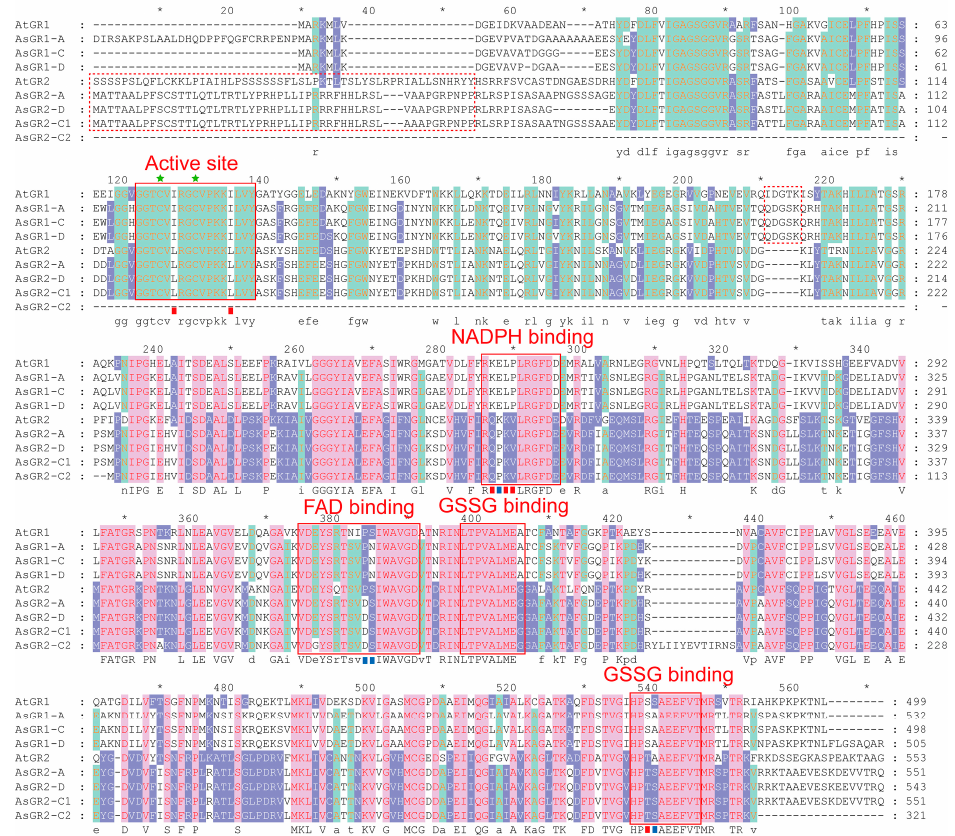
Figure 4. Multiple sequence alignments of AsGR and AtGR proteins. The active site domain, NADPH-binding domain, FAD binding domain, and GSSG binding domain in GR proteins are indicated with a red solid box. The targeting signal peptide for chloroplastic and cytosolic isoforms are showed in red dotted box. Green stars show the cysteine residues involved in catalytic site. Red squares highlight the amino acid substitutions in the GR specific structural domains of cytosolic and chloroplastic GRs. Blue squares highlight the amino acid substitutions in the GR specific structural domains of in AsGRs only.